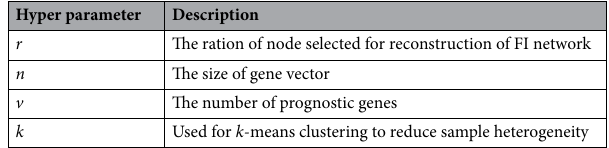
Table 3. Descriptions of